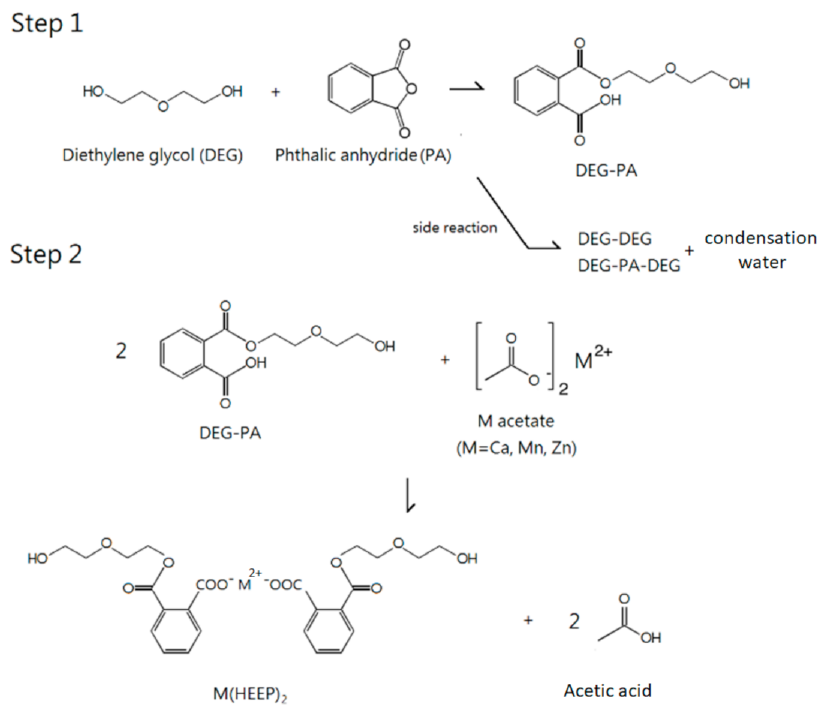
Figure 1. The synthesized process of M(HEEP) 2